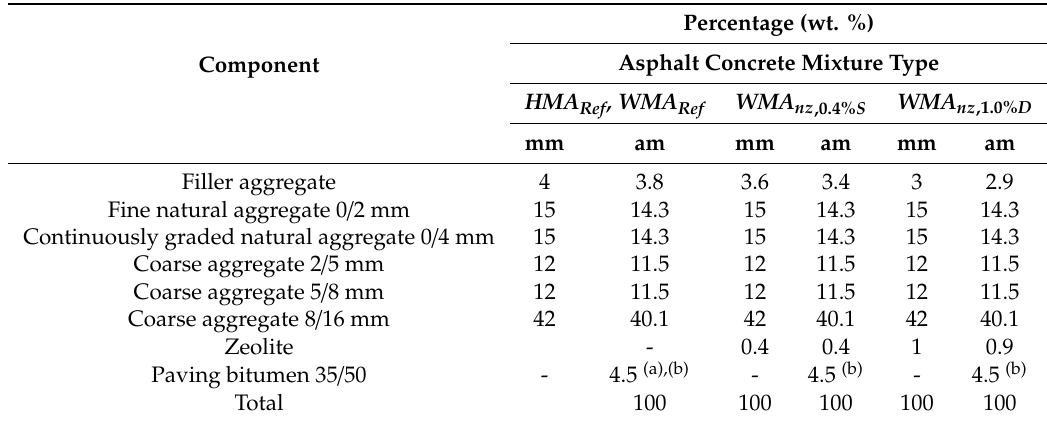
Table 5. Framework composition of the investigated AC 16 asphalt mixes.